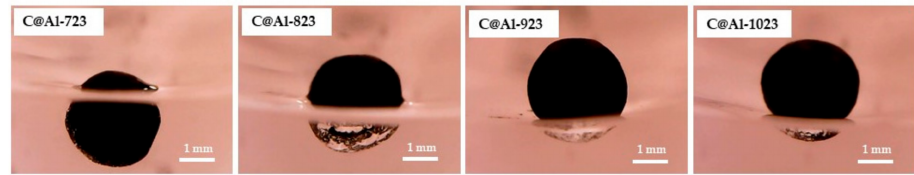
Figure 6. Images of the C@Fe–Al 2 O 3 hybrid samples floating at the distilled water